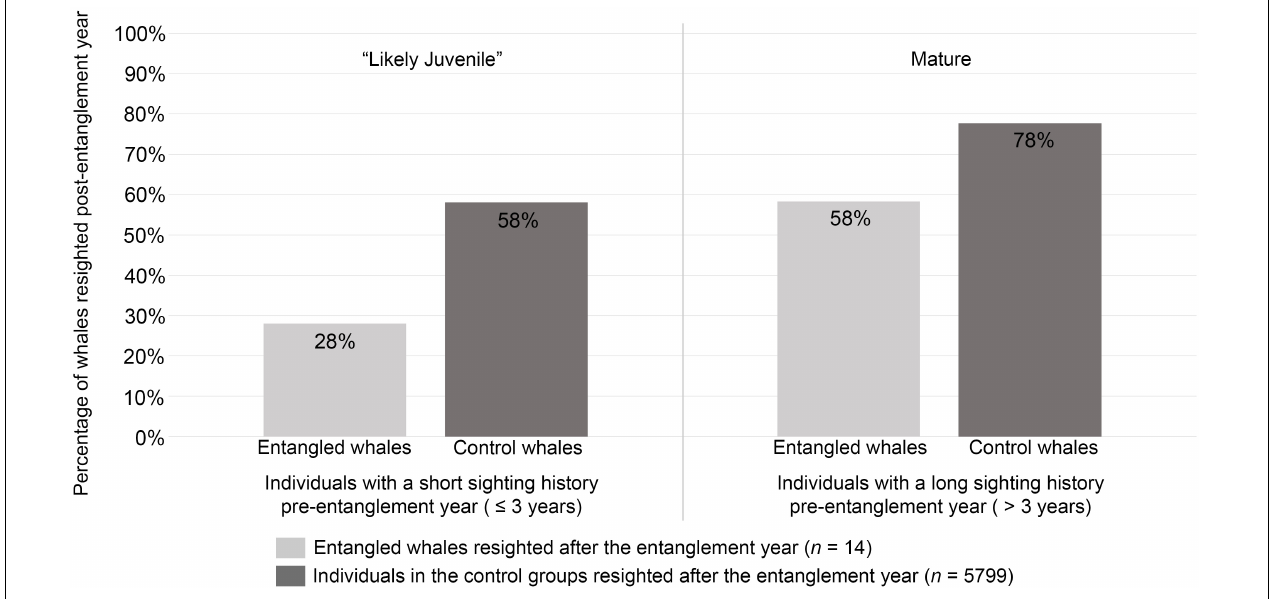
FIGURE 2 | Percentage of whales seen post-entanglement grouped by their sighting history length as a proxy for age-class. Fewer “likely juveniles” were resighted compared to mature individuals, regardless of being entangled or not ( χ 2 = 369.73, df = 1, p-value < 2.2e-16). However, the sighting history length did not account for the difference in resighting rates, since a smaller percentage of both “likely juvenile” (28%, n = 7) and mature entangled whales (58%, n = 7) were resighted compared to their counterparts in the control group (“likely juvenile”: 58%, n = 1,839; mature: 78%, n =